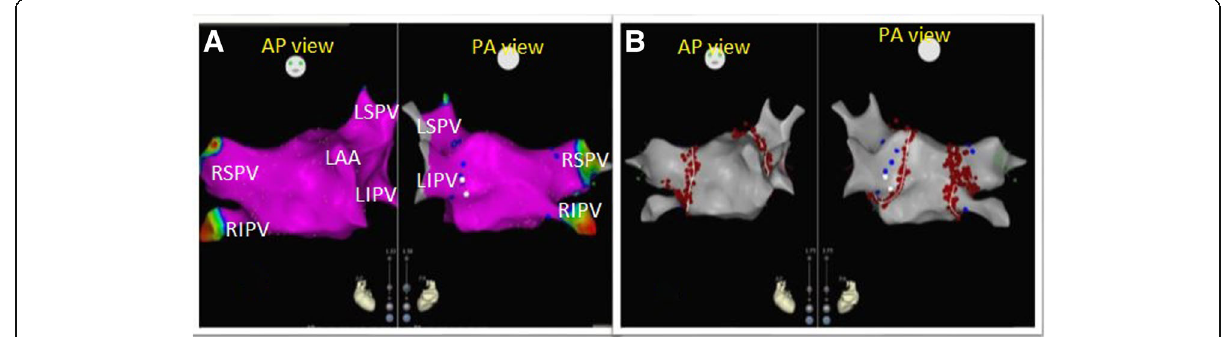
Fig. 1 Three-dimensional mapping of the left atrium (LA) and pulmonary veins (PVs) in a patient from the young population group with paroxysmal AF. a Normal bipolar voltage map of LA and four separate PVs. b Circumferential pulmonary vein isolation was performed in the same patient. LSPV: left superior pulmonary vein, LIPV: left inferior pulmonary vein, RSPV: right superior pulmonary vein, RIPV: right inferior pulmonary vein, LAA: left atrial appendage, AP view: anteroposterior view, PA view: posteroanterior view